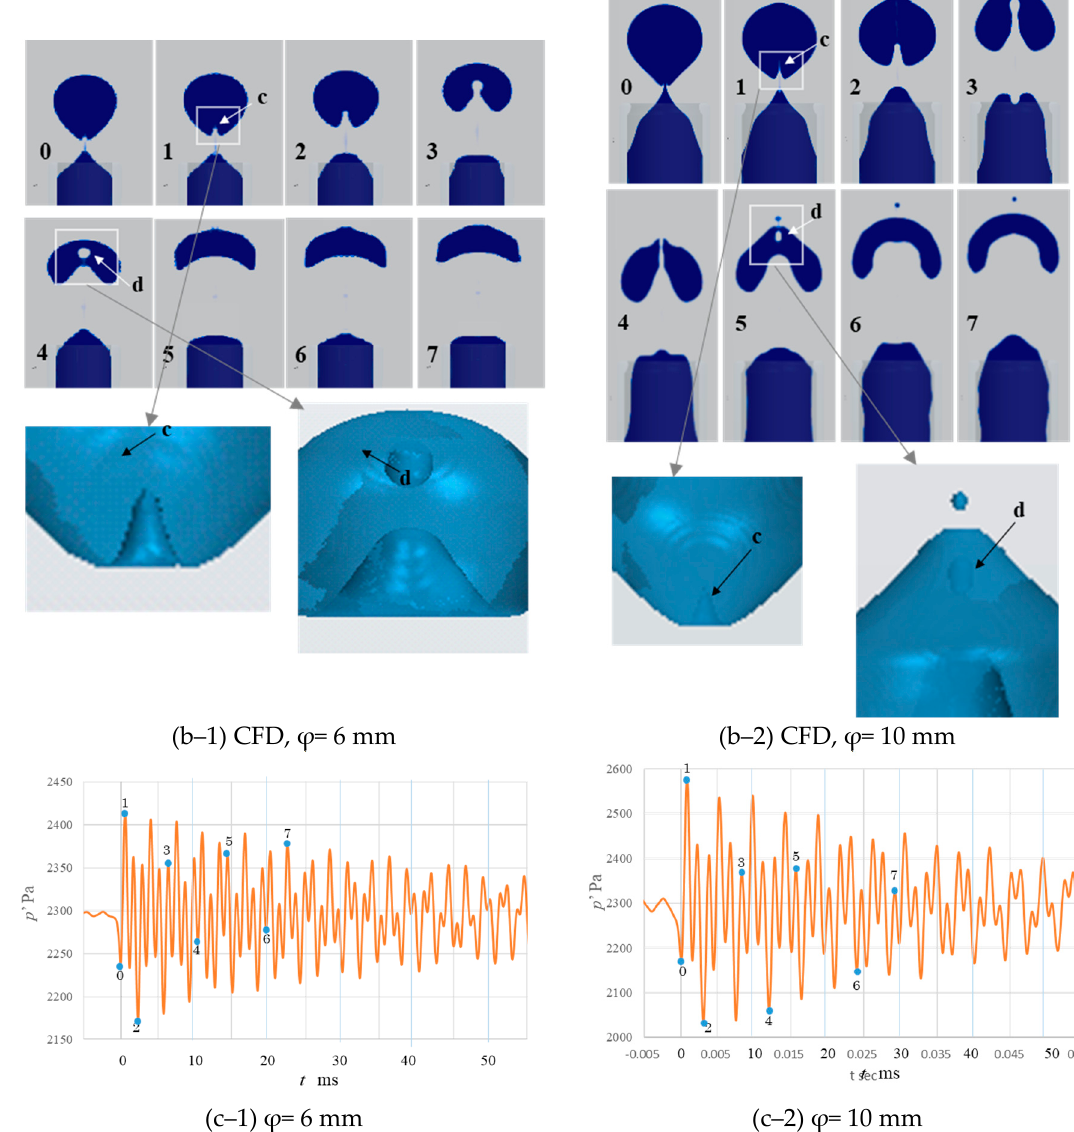
Figure 7. Bubble deformation process. ( a ) Photo images in experiment. ( b ) Bubble deformation in CFD. ( c ) Pressure profile of CFD.